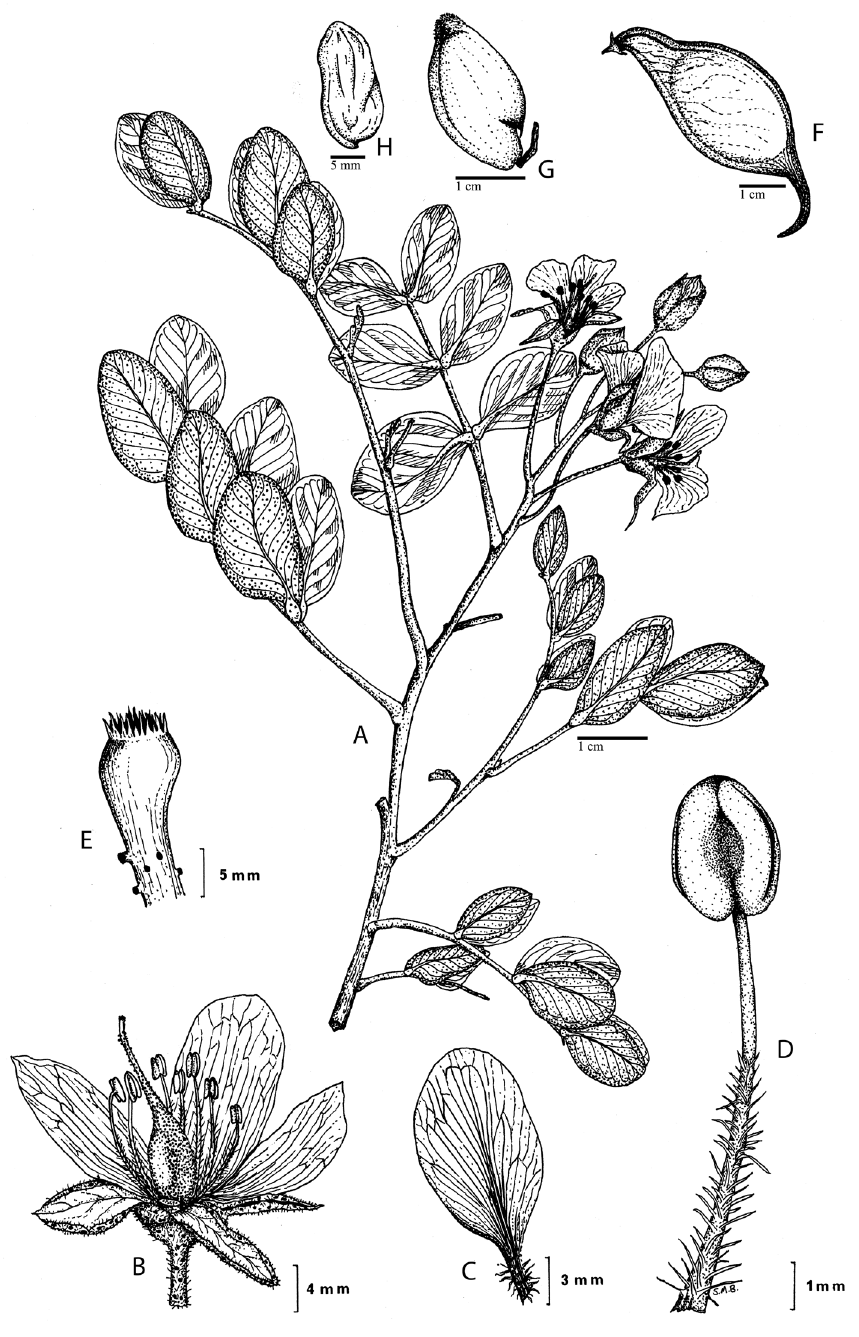
Figure 26. Cordeauxia edulis Hemsl. A branch with foliage and flowers B flower C petal D stamen E stigma F fruit G seed H seed with testa removed. A, C–E from Thulin & Warfa 4610 B from Hemming 375 F from Wood 2184 G, H from Cordeaux s.n. (type). Drawn by unknown